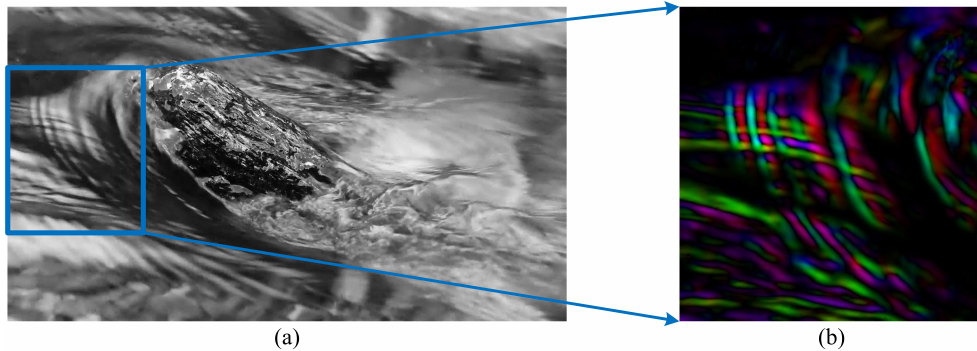
Figure 4. Turbulence image and its locally scaled HSV optical flow diagram: ( a ) turbulence image and ( b ) locally scaled HSV optical flow diagram of turbulence image.